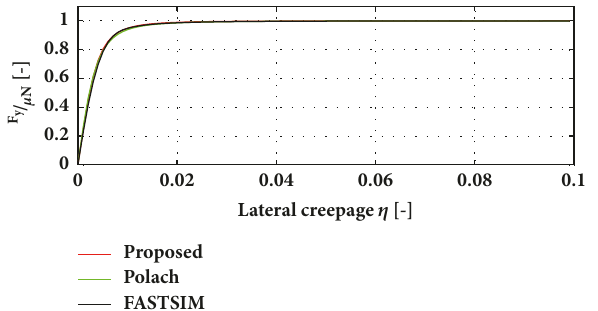
Figure 8: Lateral force versus lateral creepage in presence of a constant longitudinal creepage ( 𝜉 = 0.003).